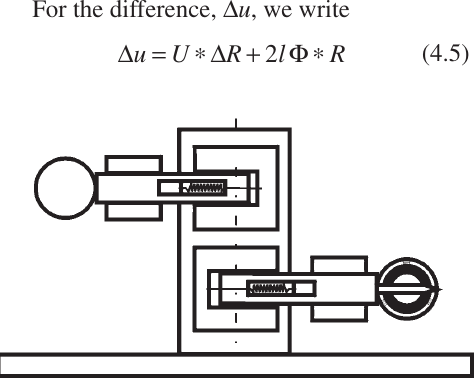
Fig. 2a. Rotation seismograph: